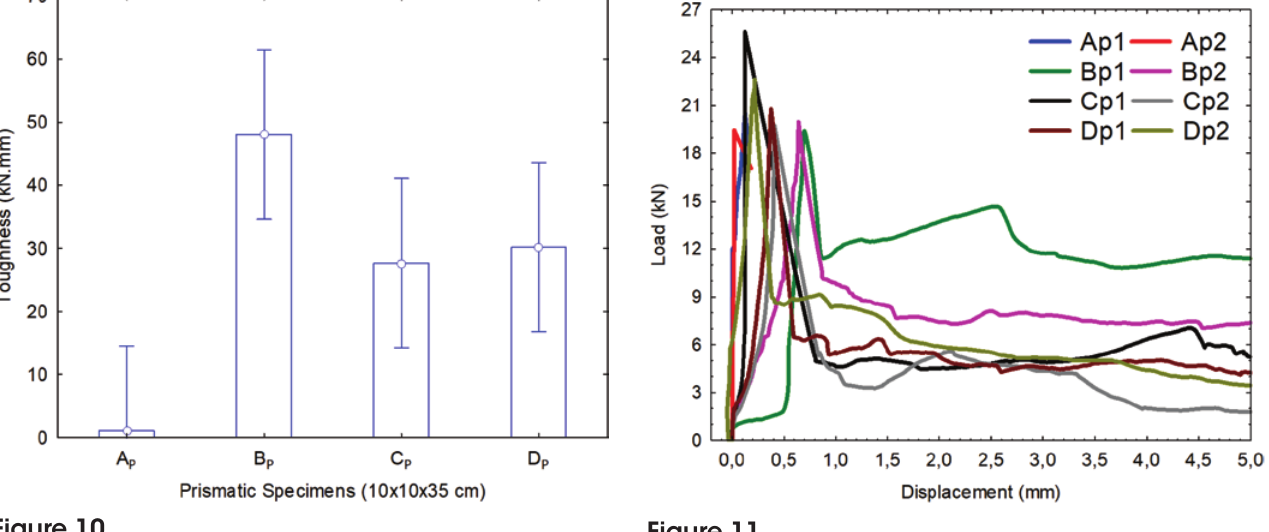
Analysis of toughness results in prismatic specimens (10 × 10 × 35 cm)